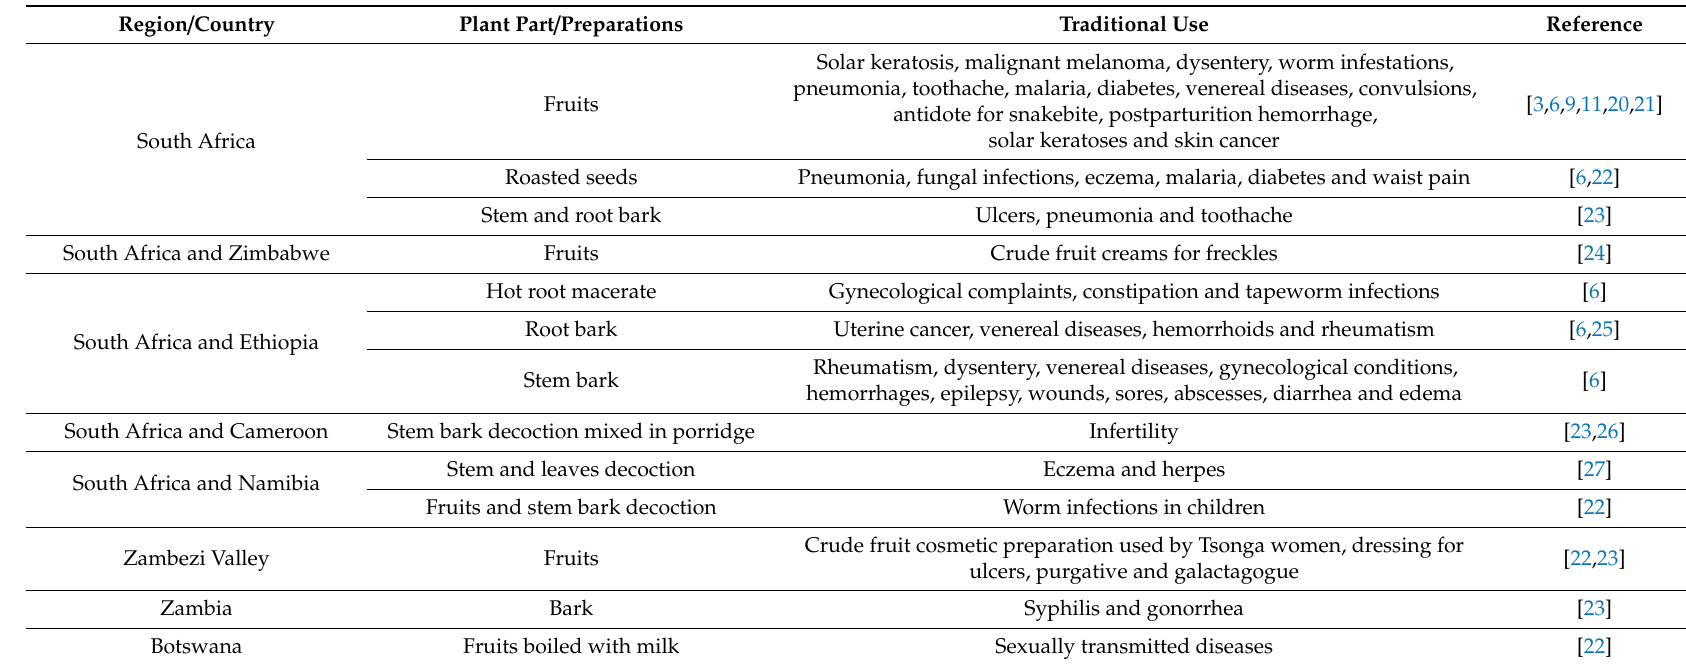
Table 1. Traditional uses of Kigelia africana (Lam.) Benth. in